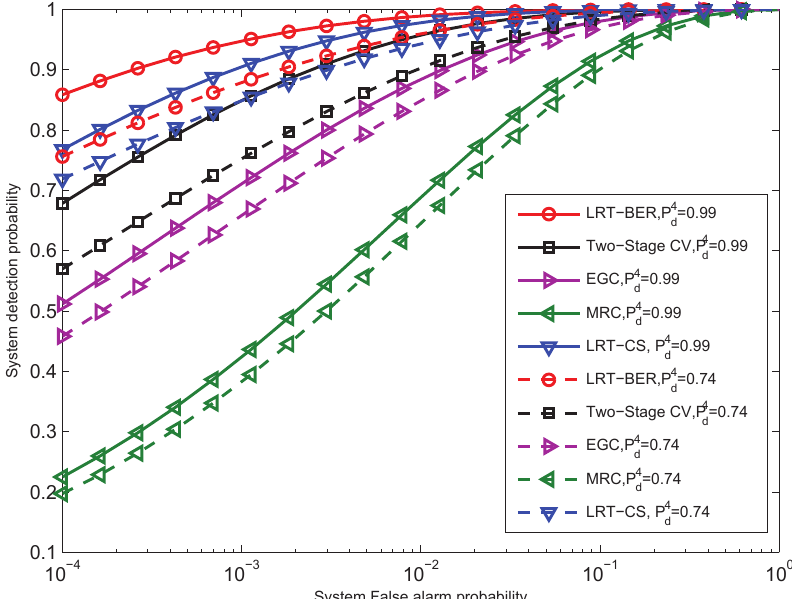
Figure 8. ROC curves of LRT-BER, MRC, EGC and LRT-CS statistics with different local detection probabilities and different received SNRs by using the CLT approximation. The = 0 . 1 . BPSK modulation and the Rayleigh fading local false alarm probability is P fa assumption are